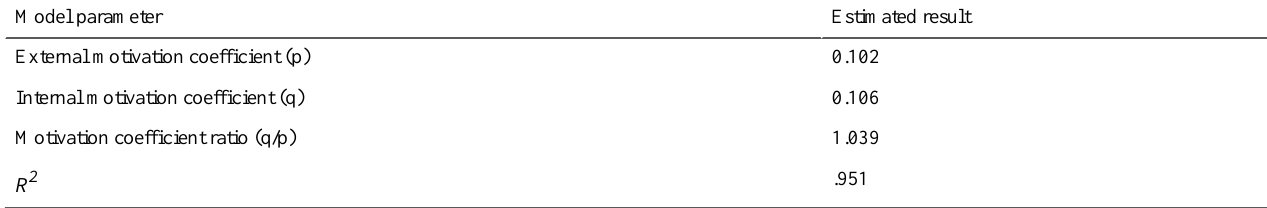
Table 1. The estimating parameters for Chinese hospitals’adoption rate of electronic medical